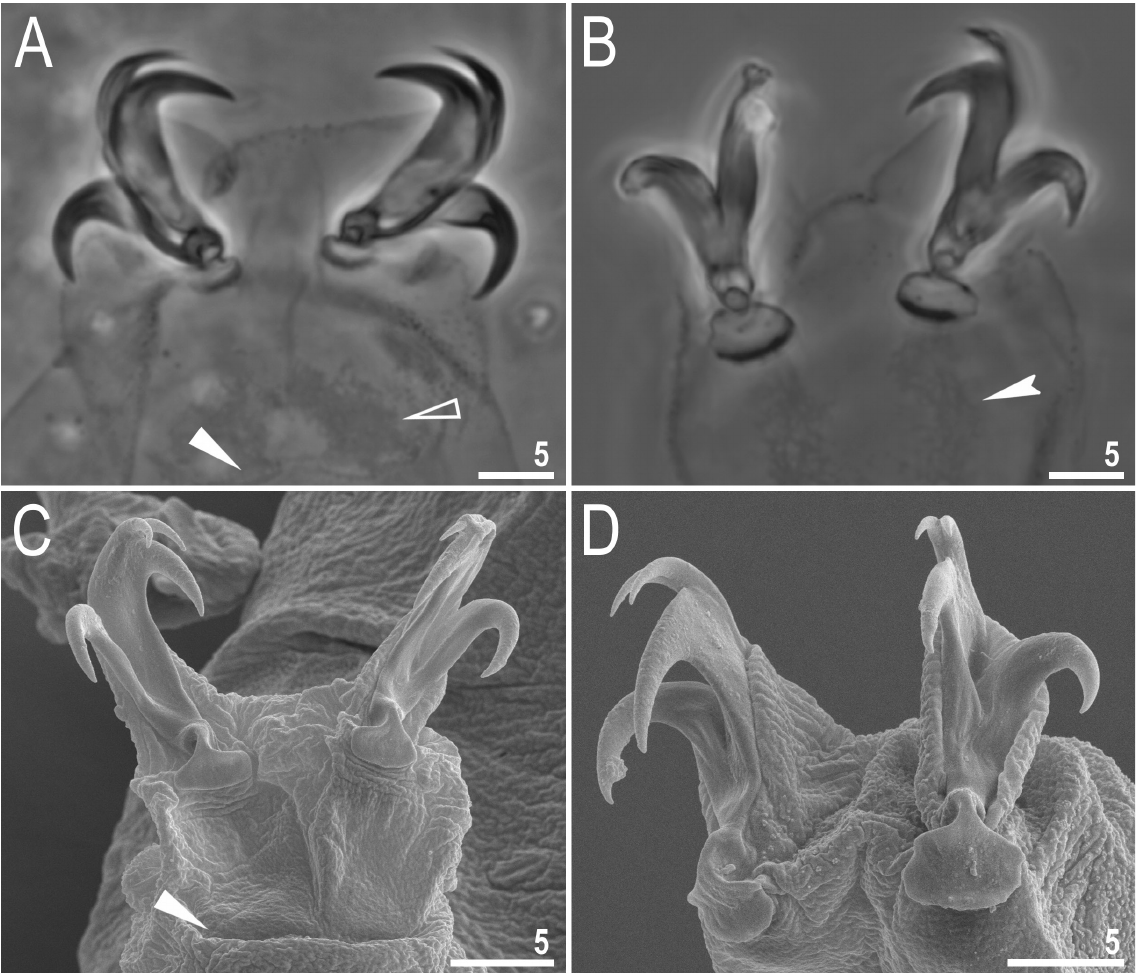
Fig. 4. Macrobiotus engbergi sp. nov. Claws (paratypes). A – B . Claws III and IV seen in PCM, respectively. C – D . Claws III and IV seen in SEM, respectively. Filled flat arrowheads indicate double muscles attachments under the claws, empty flat arrowhead indicates inverted horseshoe structure under the external and the internal claw, whereas filled indented arrowhead indicates horseshoe structure connecting the anterior and the posterior claw. Scale bars in